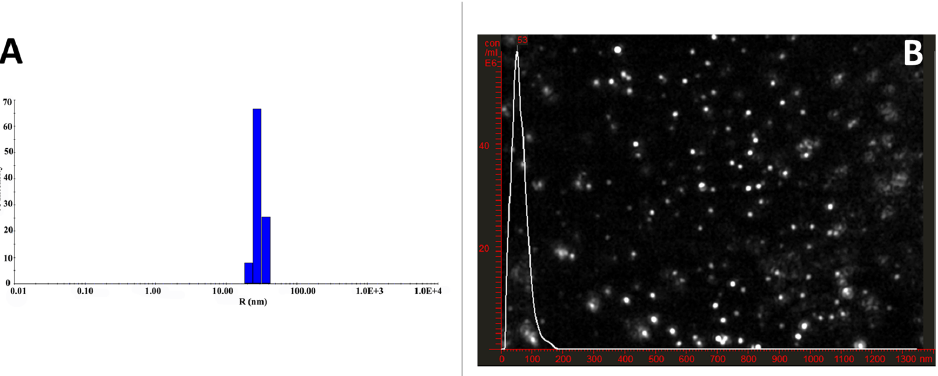
Figure 2. Characterization of ZnO NPs. ( A ) representative histogram of the size (diameter) distribu- tion by the number of ZnO nanoparticle ( B ) A video frame of nanotracker analysis (NTA) with a single peak measurement and an average of 53 ± 3.5 nm without any visual aggregations.